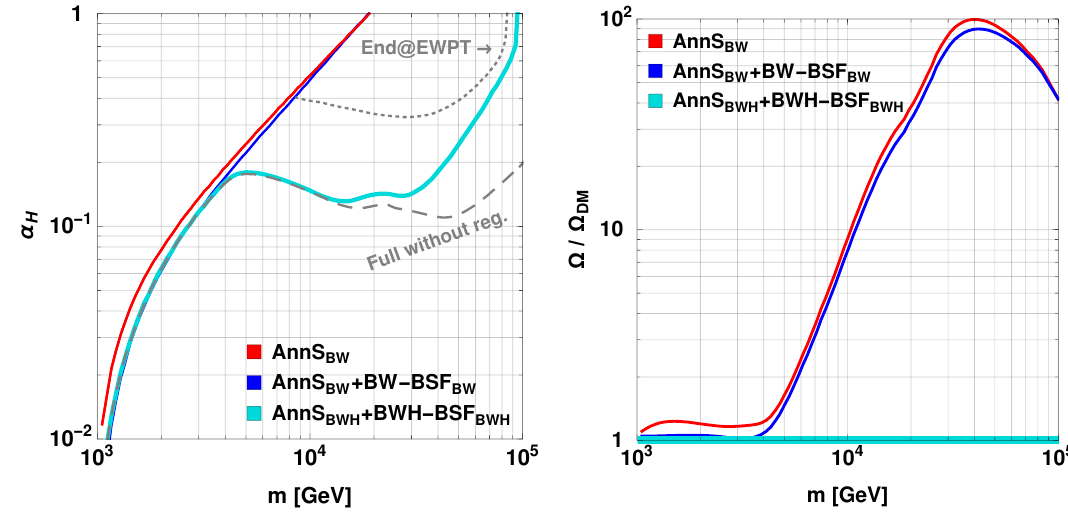
Figure 6 . Left: α H vs. m such that the observed DM density is attained via thermal decoupling, when different combinations of effects are considered, as described in table 3. Note that the DM √ mass is m = m − 4 πα with v 246 GeV , and does not differ substantially from m DM H v H H ’ along any of the lines. In grey lines, we show the result if the Boltzmann equations are integrated only up until the EWPT ( dotted ), and if the cross-sections are not regulated according to [35, section 3.6] ( dashed .) Right: the effect of the various processes on the relic density. For all lines, α H is determined as a function of m by the full computation on the left (cyan line), but for each line here the Boltzmann equations include only the processes indicated in the legend.